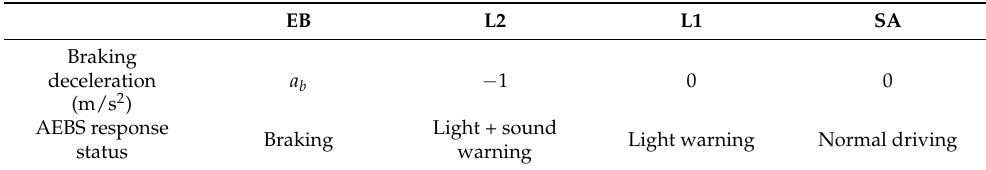
Table 6. Braking deceleration and vehicle status in each